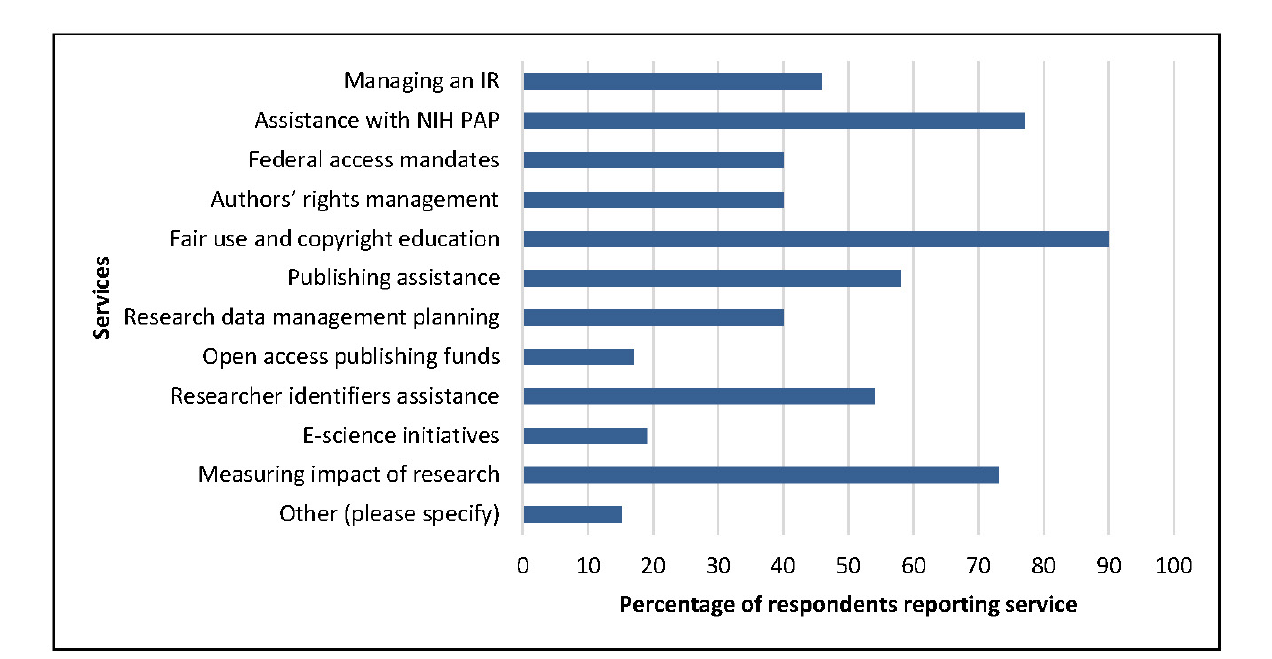
Figure 1 Association of Academic Health Sciences Libraries (AAHSL) members’ reported scholarly communications